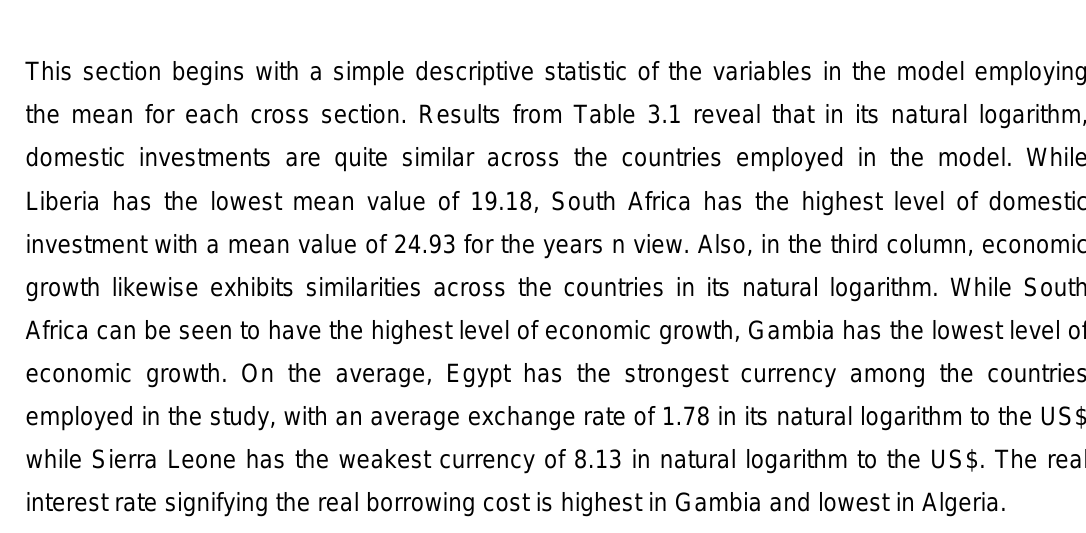
Table 3.1. Mean of Variables across Countries,